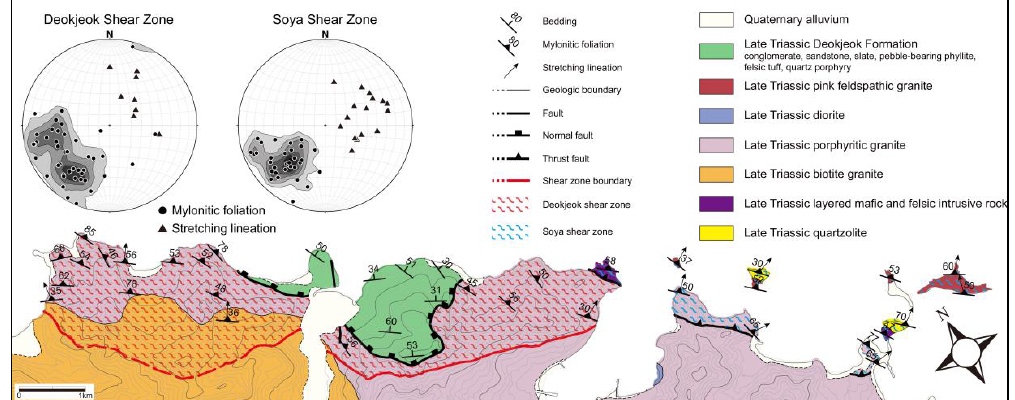
Figure 2. Geological map and cross-sections of the Deokjeok and Soya islands. Sample locations for U-Pb dating are shown on the map. The gray rectangle indicates the location of Figure 3. B.T.—Buk-ri Thrust.